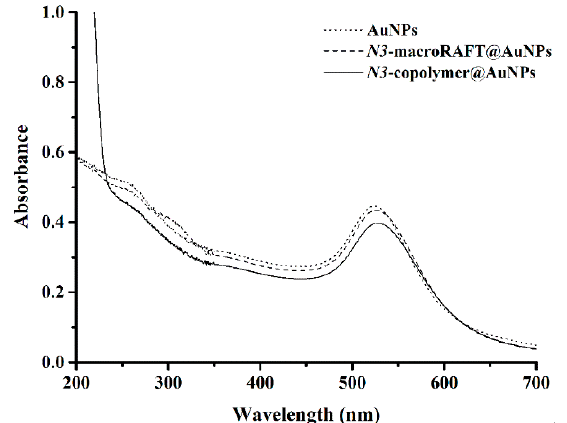
Figure 3. UV-Vis spectra of Au nanostructures before and after emulsion copolymerization at 44 °C, with azide moiety. Table 2. λ LSPR , DLS, and zeta potential ( ζ ) measurements of Au nanostructures before and after